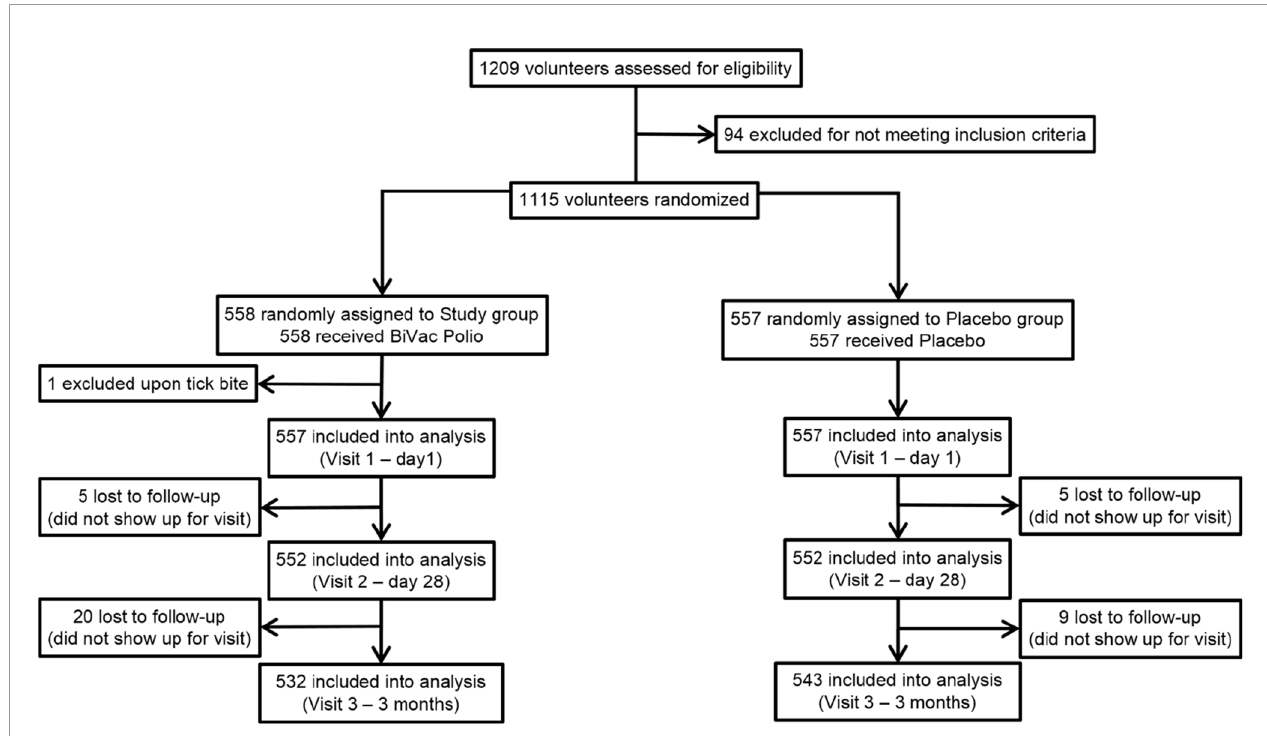
FIGURE 1 | Flow Diagram of the